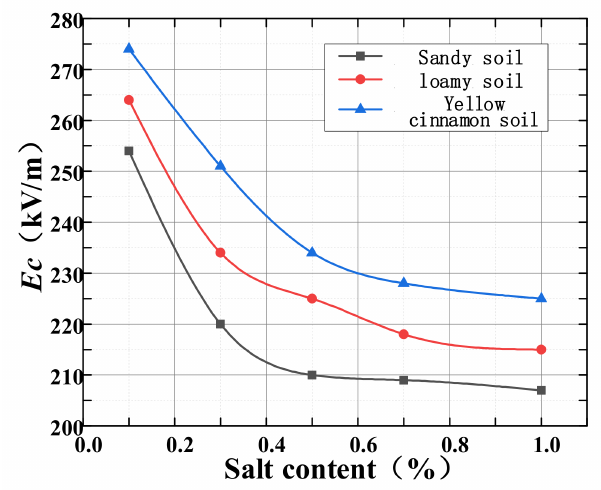
Figure 6. The influence of salt content on the critical breakdown field strength of soil. In the case of 0.1~1% salt content, it can be seen from Figure 6 that the critical breakdown field strengths of sand, loam and Yellow cinnamon soil are between 207 kV/m~254 kV/m, 215 kV/m~264 kV/m and 225 kV/m~274 kV/m. As the salt content increases, the Ec of the three soils all show a change situation that first decreases and then tends to saturation.